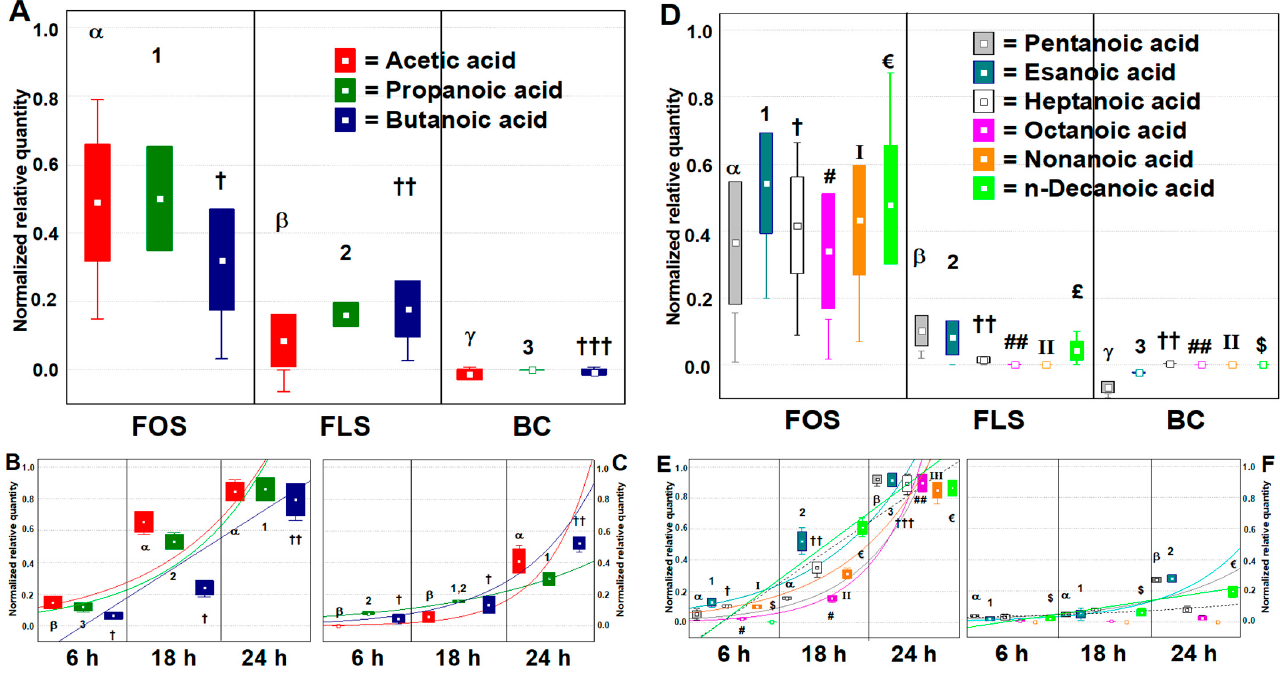
Figure 2. Changes in main microbial metabolites related to prebiotic activity expressed as a normalized scale from relative abundances in respect to the baseline value (BL = 0.0). FOS = fructooligosaccharides; FLS = tested fiber; BC = blank control. The bigger plots show changes over gathered time points, while the smaller plots show changes after specific time points, including tendency lines. The baseline absolute quantifications in mg/kg are found in the supplementary material (Table S1). Changes were recorded over and after 24 h of in vitro batch human colonic fermentations with 1% ( w / v ) FOS and FLS.